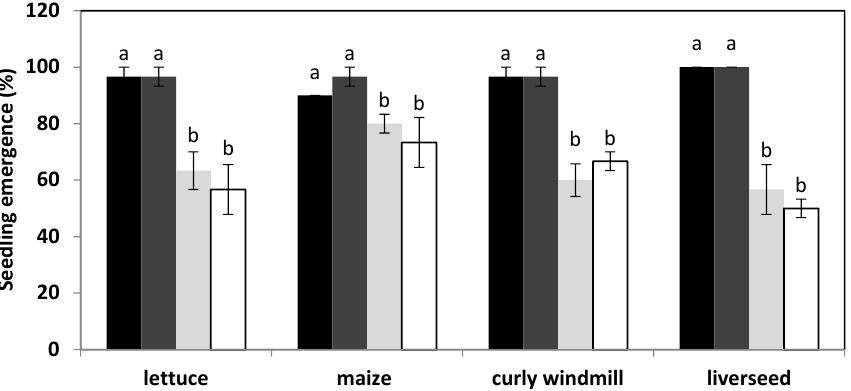
Figure 1. Seedling emergence percentage for lettuce, maize, curly windmill grass, and liverseed grass when seeds were sown into soil collected from a parthenium weed-infested site, either collected from the 0 to 10 cm (light grey) or 10 to 20 cm depth (white), and in soil collected from a non-infested soil collected from the 0 to 10 cm (dark grey) or 10 to 20 cm (black). Error bars represent two standard deviations from the mean, as calculated for 24 replicate pots of 30 sown seeds. Means within species that do not share the same letter are significantly different from one another at p > 0.05.